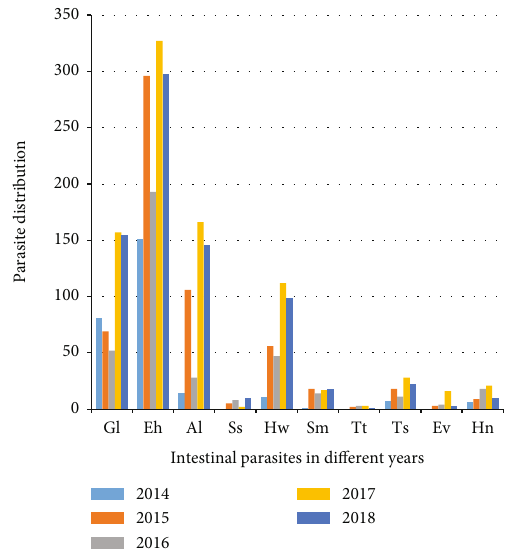
Figure 1: Intestinal parasite distribution at University of Gondar students ’ clinic, Gondar, Northwest, Ethiopia. Gl: Giardia lamblia; Eh: Entamoeba histolyitca/dispar; Al: Ascaris lumbricoides; Ss: Strongyloides stercoralis; Hw: hookworm; Sm: Schistosoma mansoni; Tt: Trichuris trichiura; Ts: Taenia species; Ev: Enterobius vermicularis; Hn: Hymenolepis nana.